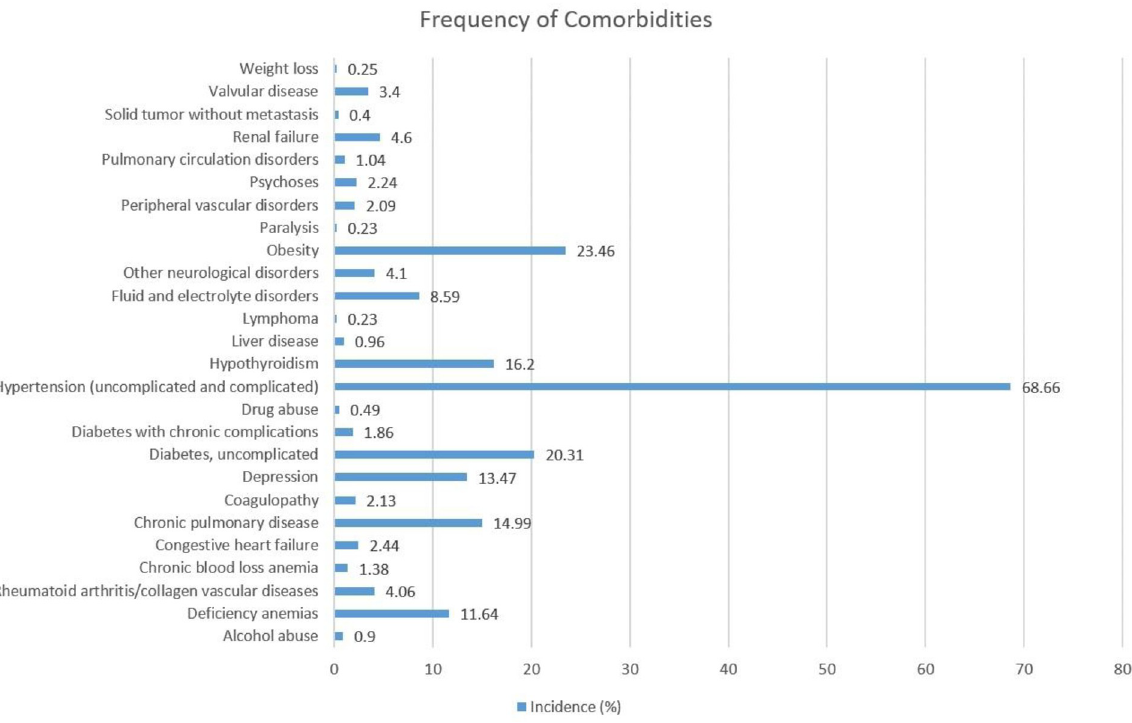
Fig 2. Frequency of comorbidities in the 2010–2014 NIS study